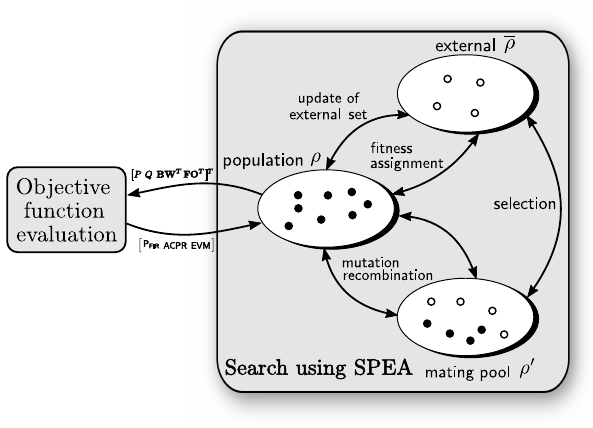
Figure 3. Multiobjective optimization model for DPD